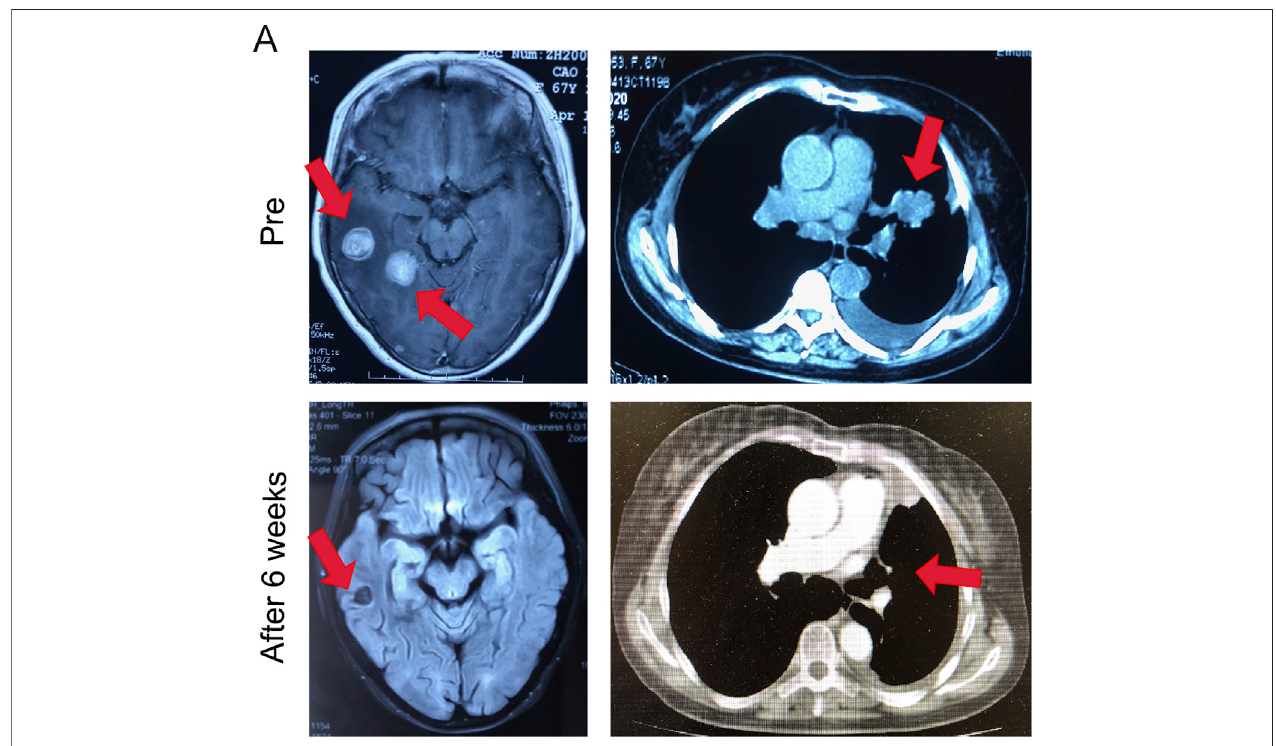
FIGURE6| Almonertinibdemonstratedpotentanti-tumoractivityinapatientwithEGFRmutantNSCLC.Intracranialandextracranialresponseaftertreatmentwith 110 mg almonertinib in a 67-year old female patient with the EGFR mutation.